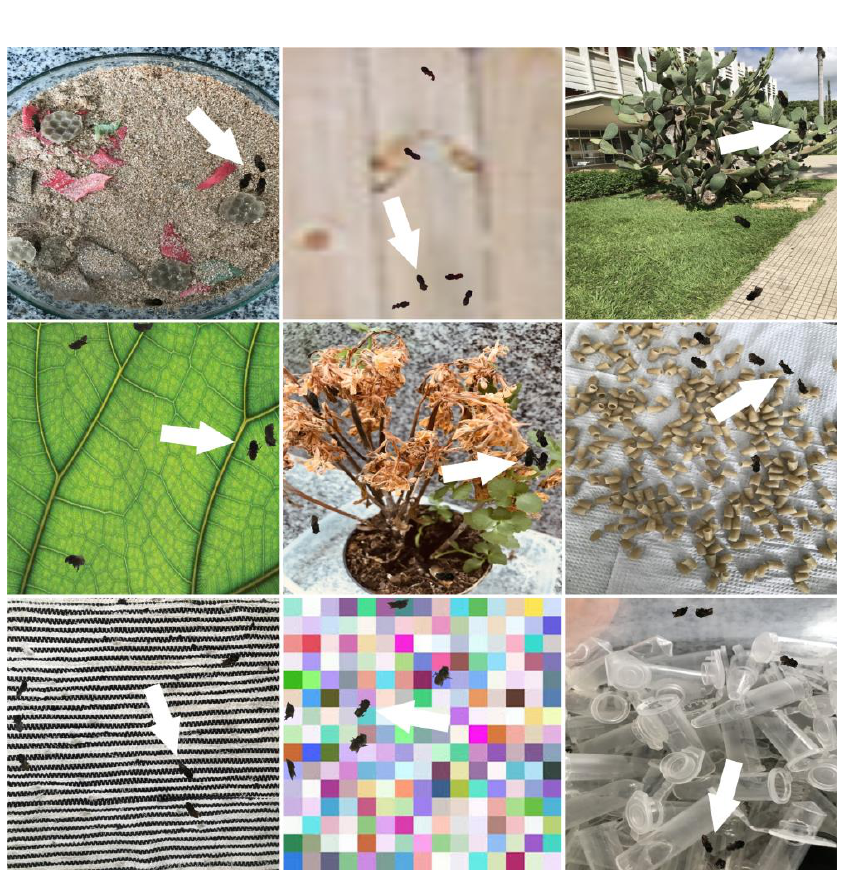
Figure 4. Examples of some images that were generated automatically to train the model for tracking the stingless bee Melipona quadrifasciata in different conditions of a heterogeneous background. The white arrows indicate some bee contours pasted in the backgrounds.